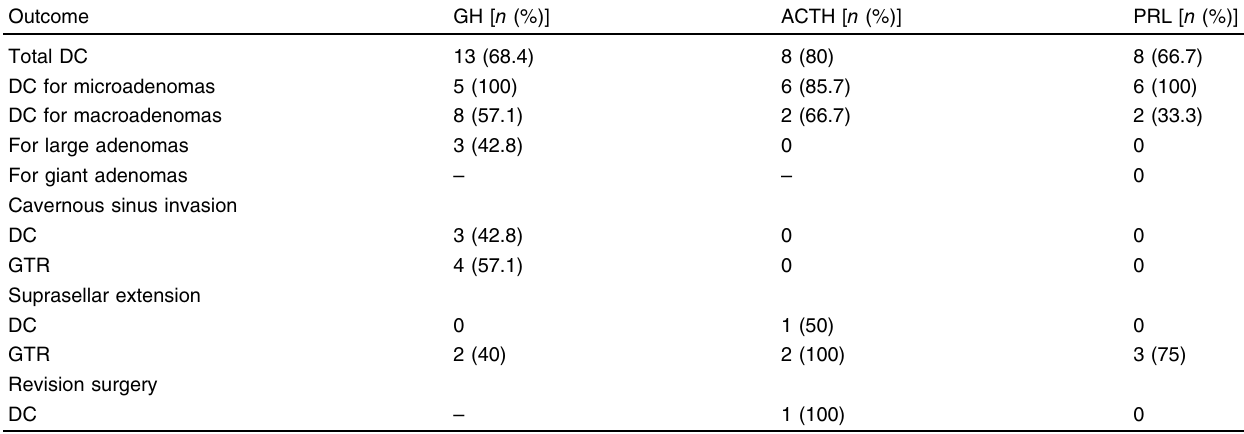
Table 4 Surgical outcome for functioning pituitary adenomas Outcome